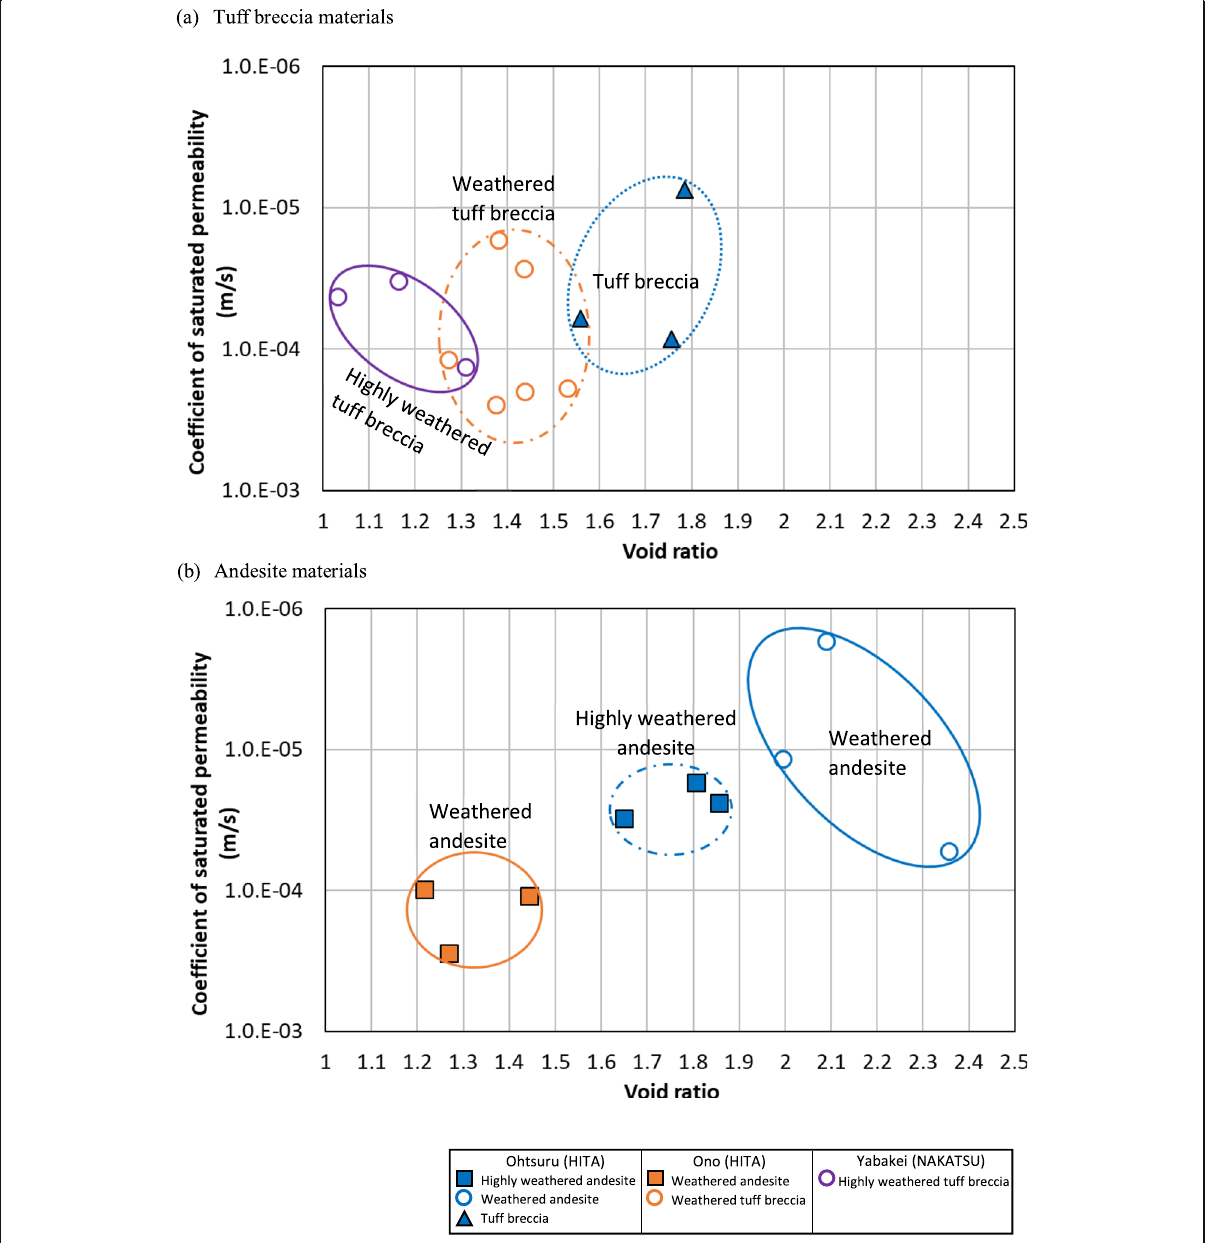
Fig. 12 Correlation between coefficient of permeability (m/s) and void ratio on ( a ) tuff breccia materials and ( b ) andesite